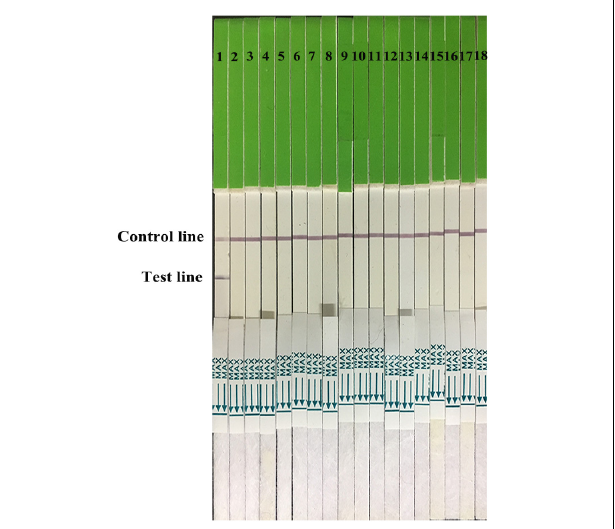
FIGURE 3 | Strip specificity. 1: H7 positive AIV. 2–12: H1 AIV, H3 AIV, H4 AIV, H5 AIV, H6 AIV, H8 AIV, H9 AIV, H10 AIV, H11 AIV, and H12 AIV. 13–16: NDV, IBV, MDV, and IBDV. 17, 18: PBS and